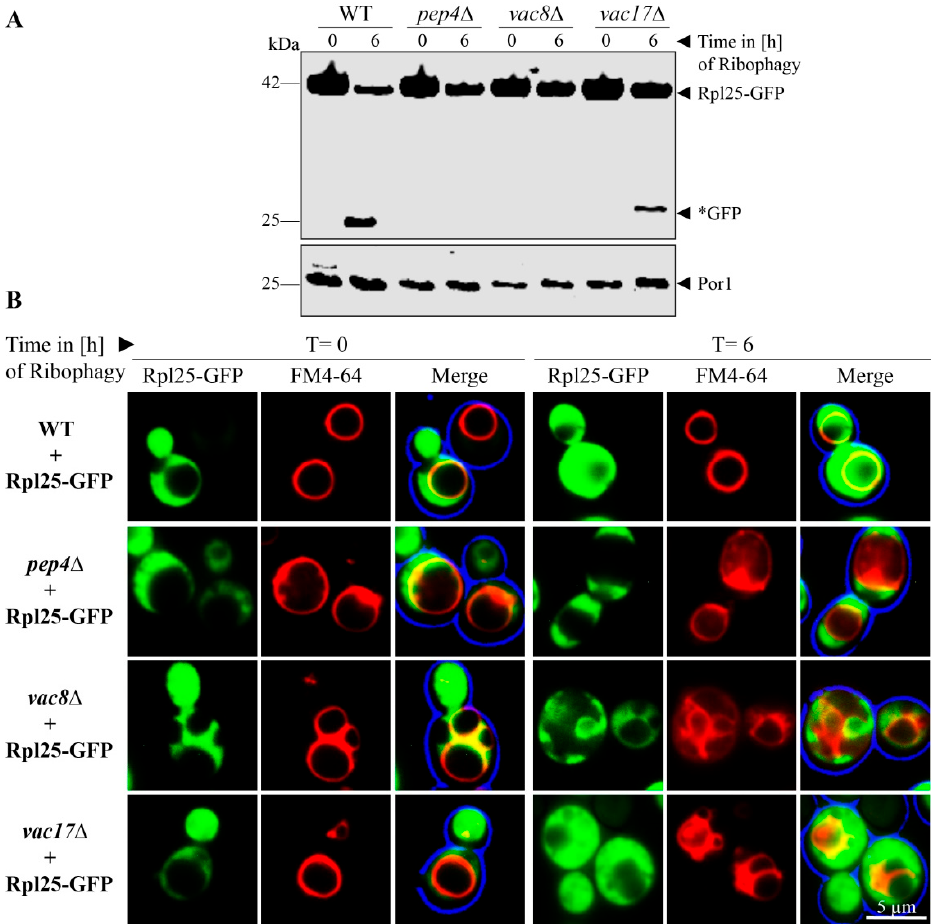
Figure 4. Vac8 is essential for ribophagy. ( A ) The possible contribution of Vac8 and Vac17 to ribophagy was analyzed via the stability of the ribosomal protein Rpl25, which was genetically fused to GFP. In wild-type (WT) and vac17 Δ cells, the Rpl25-part of the fusion protein is degraded in the vacuole together with the rest of the organelle, while the GFP portion is largely stable (*GFP). This process is blocked in pep4 Δ and vac8 Δ cells. ( B ) Ribosomes were labeled with Rpl25-GFP for fluorescence microscopy. The vacuolar membrane was stained with FM4-64. At the end of the ribophagy assay (t = 6h), the vacuole of WT and vac17 Δ cells is mainly filled with a diffuse green staining, indicating ribsomal breakdown. The vacuole does not display GFP signals in pep4 Δ and vac8 Δ cells, indicating a defect in ribophagy.